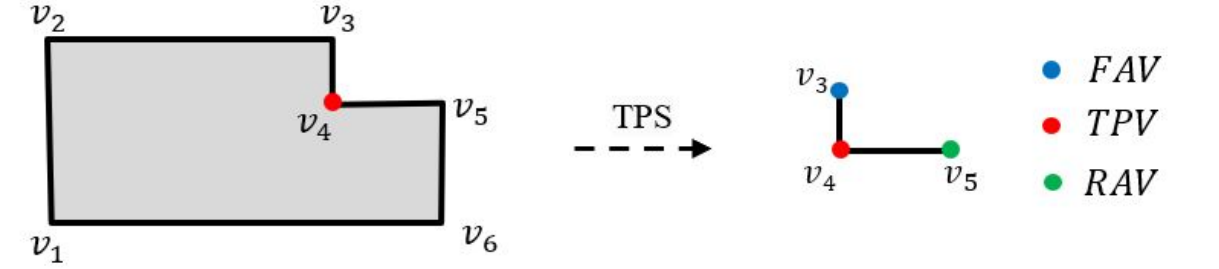
Figure 3. Determination of the TPV and TPS .